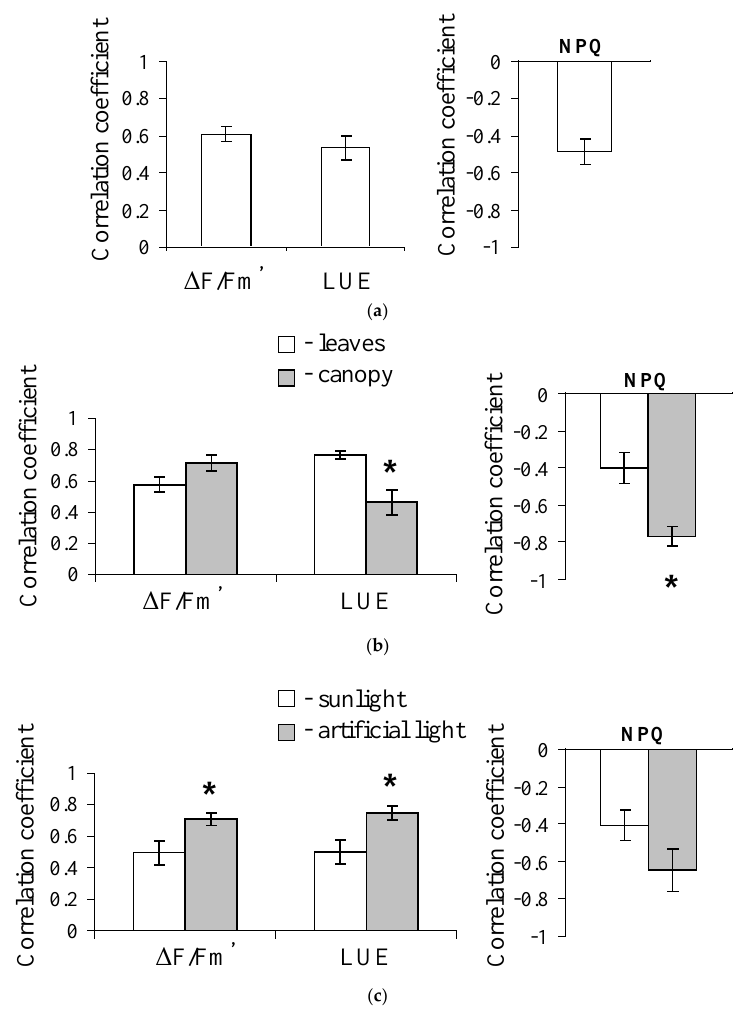
Figure 2. The connection of PRI with the quantum yield of photosystem II (ΔF/F m ’), nonphotochemical quenching (NPQ), and light use efficiency (LUE). ( a ) Average correlation coefficients of PRI with ΔF/F m ’ ( n = 110), LUE ( n = 63), and NPQ ( n = 50); ( b ) Average correlation coefficients of PRI with ΔF/F m ’, LUE, and NPQ for measurements of the photochemical reflectance index in leaves ( n = 86, n = 15, n = 38, respectively) and canopy ( n = 24, n = 48, n = 12, respectively); ( c ) Average correlation coefficients of PRI with ΔF/F m ’, LUE, and NPQ with measurements under sunlight ( n = 52, n = 54, n = 33, respectively) or artificial light ( n = 58, n = 9, n = 17, respectively). * the groups significantly differed from another one ( p < 0.05, Student’s test).